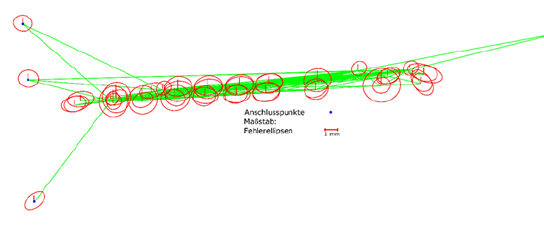
Fig. 3: Network sketch of the adjusted coordinates including error ellipses.